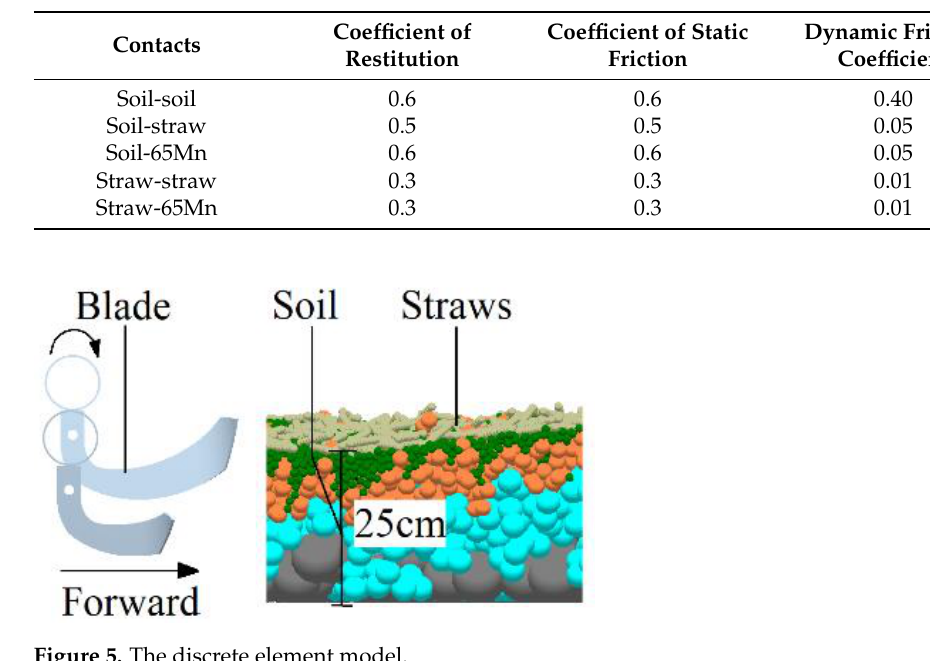
Figure 6. Initial position of the rotary blade.